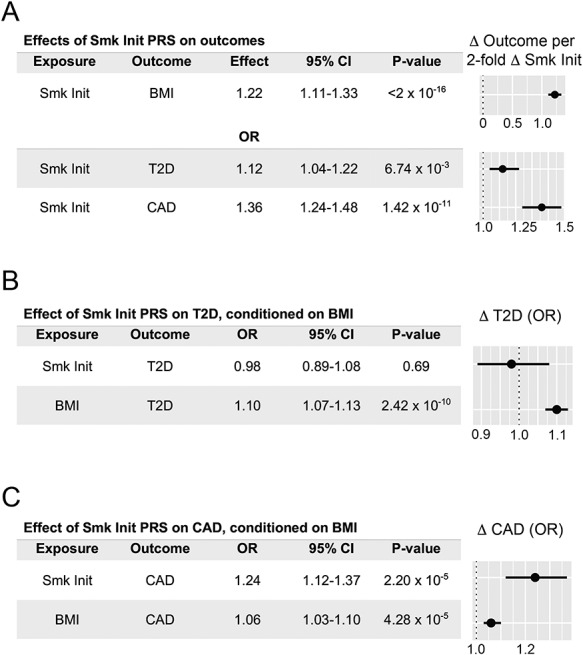
Individual-level Mendelian randomization analyses confirm that a polygenic risk score for smoking initiation increases cardiovascular risks, and that BMI mediates the effect of smoking on type 2 diabetes but not CAD. (A) A PRS based on genome-wide significant SNPs for smoking initiation increases BMI, type 2 diabetes (T2D) or CAD risks. (B) Effects from smoking initiation on type 2 diabetes are nonsignificant after adjusting for effects on BMI. (C) Effects from smoking initiation on CAD remain significant after adjusting for BMI. OR and effect estimates, 95% confidence intervals and forest plots represent changes in outcomes associated with 2-fold increase in genetic smoking initiation ‘risk’.